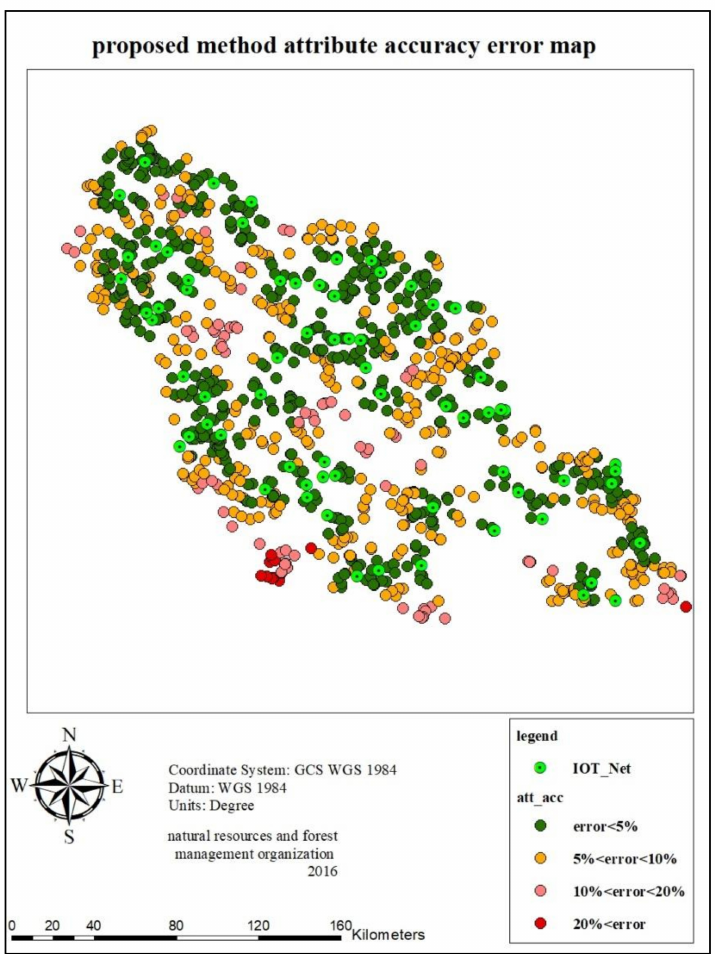
Figure 12. Attribute error map of the proposed